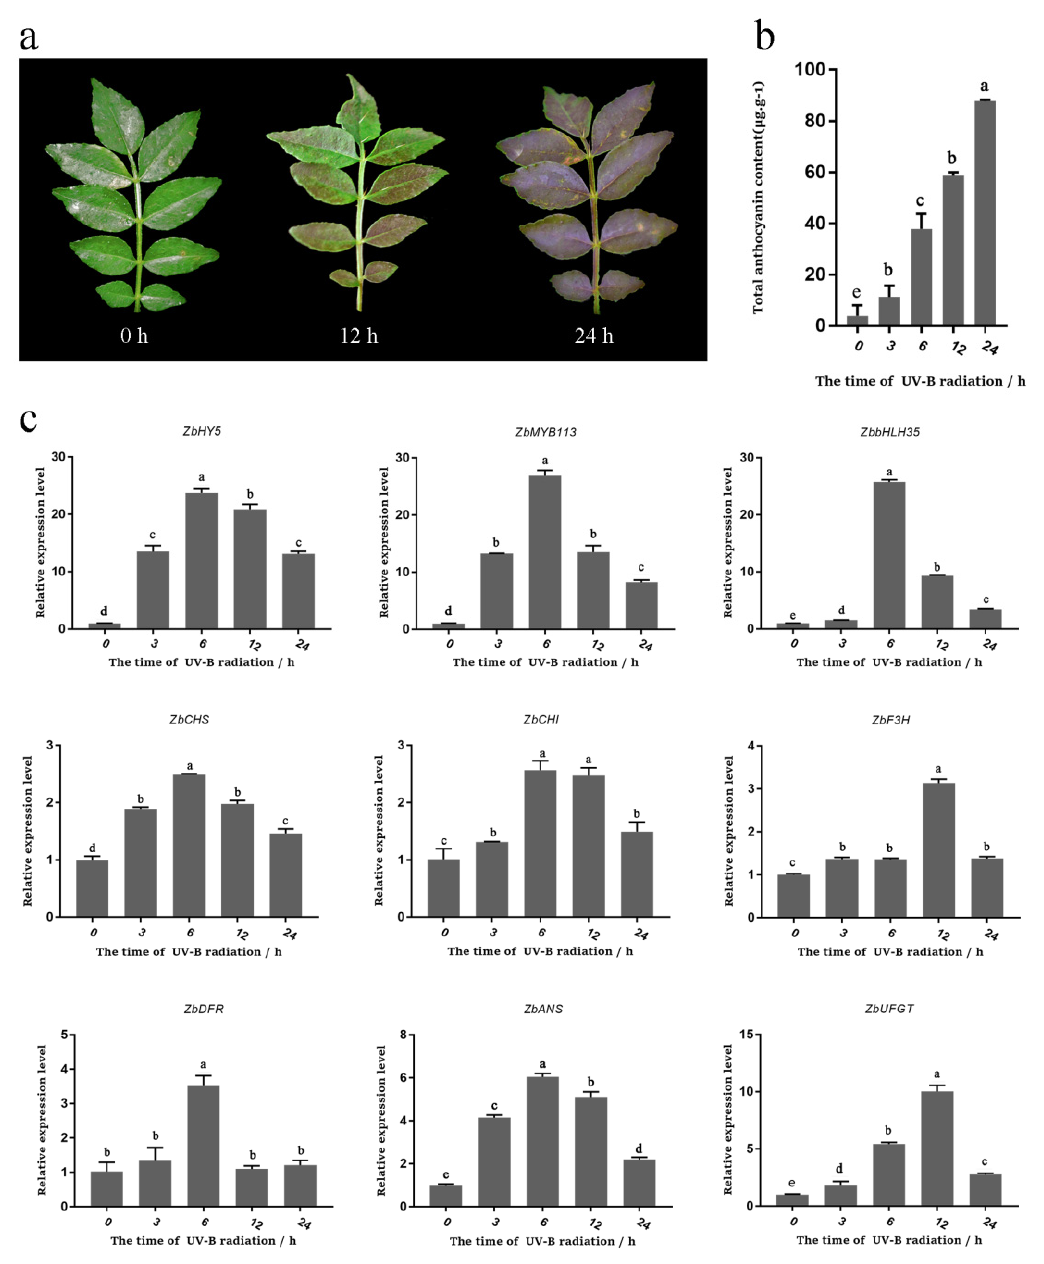
Figure 4. Changes in the total anthocyanin content and gene expression under UV-B irradiation in Z. bungeanum leaves. ( a ) Pictures of the Z. bungeanum leaves under UV-B irradiation after 0 h, 12 h, and 24 h. ( b ) The total anthocyanin content in the leaves after UV-B irradiation for 0 h, 3 h, 6 h, 12 h, and 24 h. ( c ) The expression of the transcription factor genes ( ZbHY5 , ZbMYB113 , ZbbHLH35 ) and structural genes ( ZbCHS , ZbCHI , ZbF3H , ZbDFR , ZbANS , ZbUFGT ) related to anthocyanin synthesis in the leaves after UV-B irradiation for 0 h, 3 h, 6 h, 12 h, and 24 h. Different lowercase letters indicate significant differences among treatments according to one-way ANOVA test ( p <